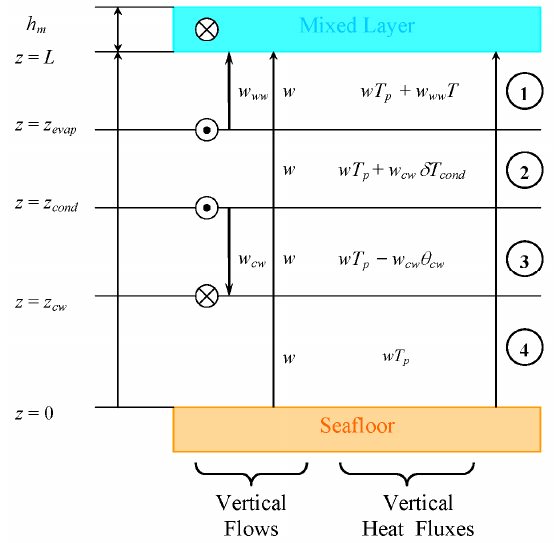
Figure 2. Schematic description of steady-state fluxes in one-dimensional model of the water column with OTEC and separate effluent discharges. OTEC seawater intakes are shown as circles with crosses, OTEC seawater effluent discharges as circles with a dot. Not shown is a heat flux wT p leaving the mixed layer ‘horizontally’ that would represent deep water formation far from the OTEC region.